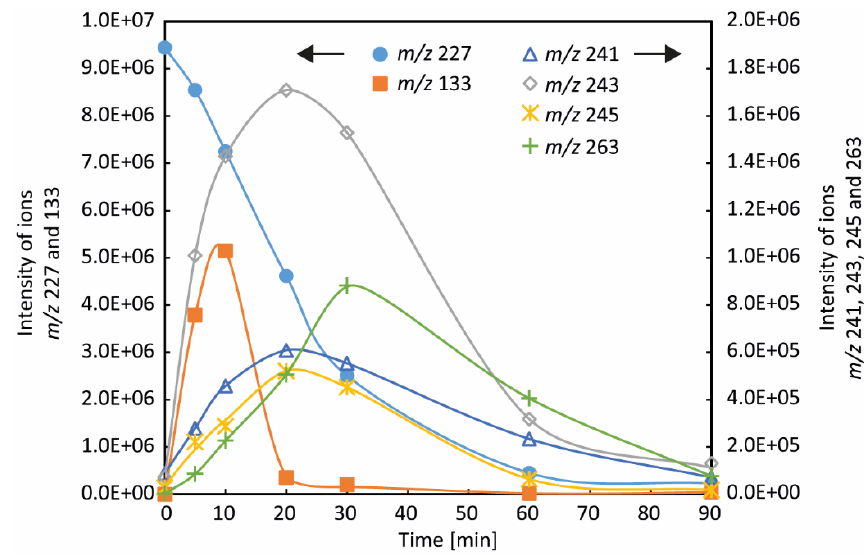
Figure 7. Formation and decay of compounds found during the photodegradation of BPA.